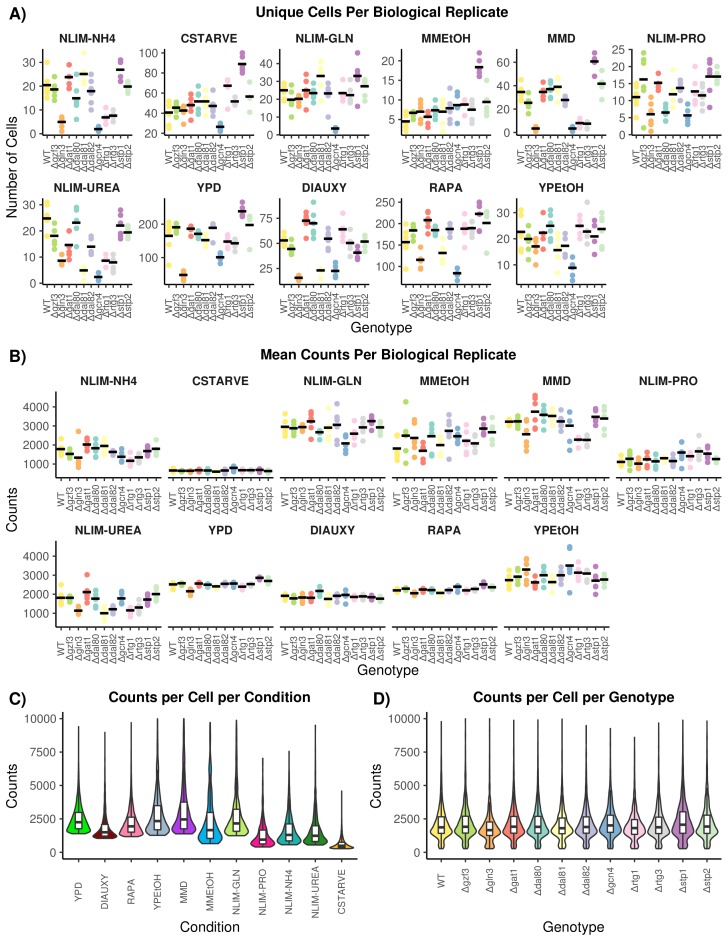
Quality Control of Single-Cell RNA Sequencing Data.(A) The number of cells that pass all quality control and preprocessing filters for each growth condition. Each genotype has multiple independently barcoded biological replicates that are plotted separately within each condition. The mean number of cells for each genotype within a condition is plotted as a horizontal line. (B) The mean count of unique transcripts, determined by UMI, for each growth condition. Biological replicates are plotted separately for each genotype within each condition. The mean number of transcripts per genotype is plotted as a horizontal line. (C) The distribution of unique transcript count per cell across all growth conditions. (D) The distribution of unique transcript counts per cell across all genotypes.